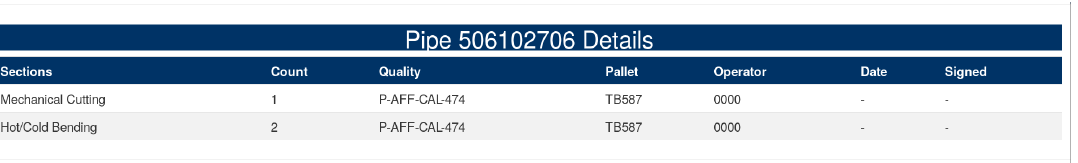
Figure 12. Details of the pipes located in a logic area.